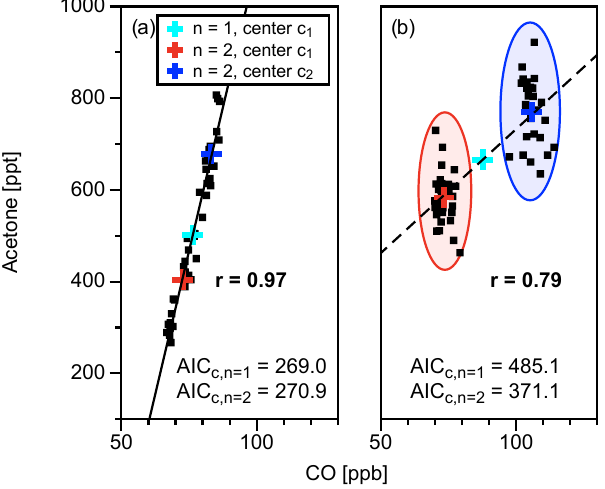
Figure 2. Scatter plots of two exemplary subsets of subsequently measured acetone and CO VMRs. (a) Shows a subset with highly correlated data ( r = 0.97) and no visible clustering, which is also confirmed by the cluster analysis (AIC C ,n = 1 ≤ AIC C ,n = 2 ). (b) Two distinct clusters are visible and automatically identified by the cluster analysis (AIC C ,n = 1 > AIC C ,n = 2 ). Although the Pear- son’s correlation coefficient indicates a good correlation ( r = 0 . 79), this subset is rejected for determination of